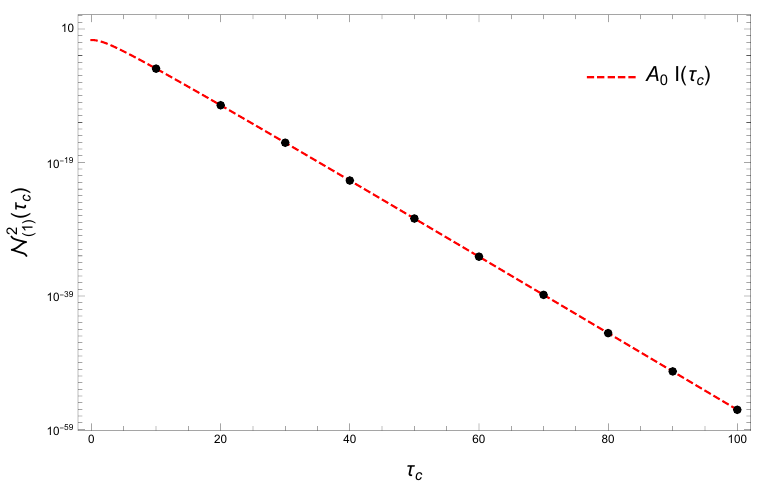
Figure 10 . Plot of N 2 ( τ c ) in the fully warped limit τ c → T . We see that the normalisations fall (1) with A 0 I ( τ c ) , with A 0 ≈ 0 . 3